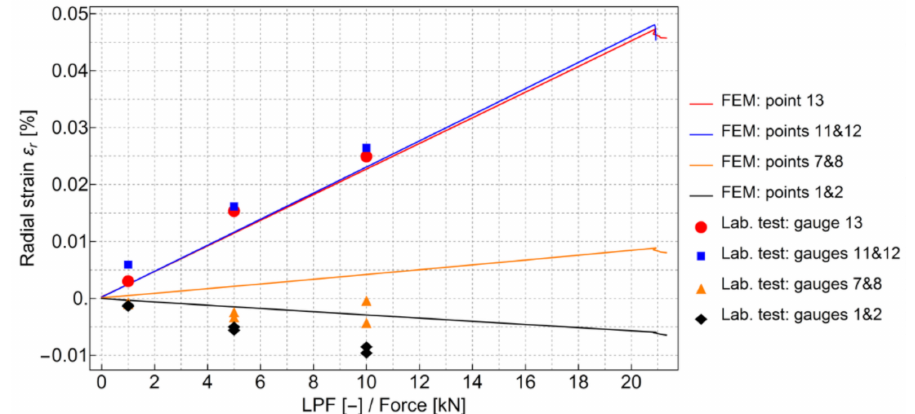
Figure 21. Comparison of radial strain between the experiment and finite element methodmodel (see also Figure